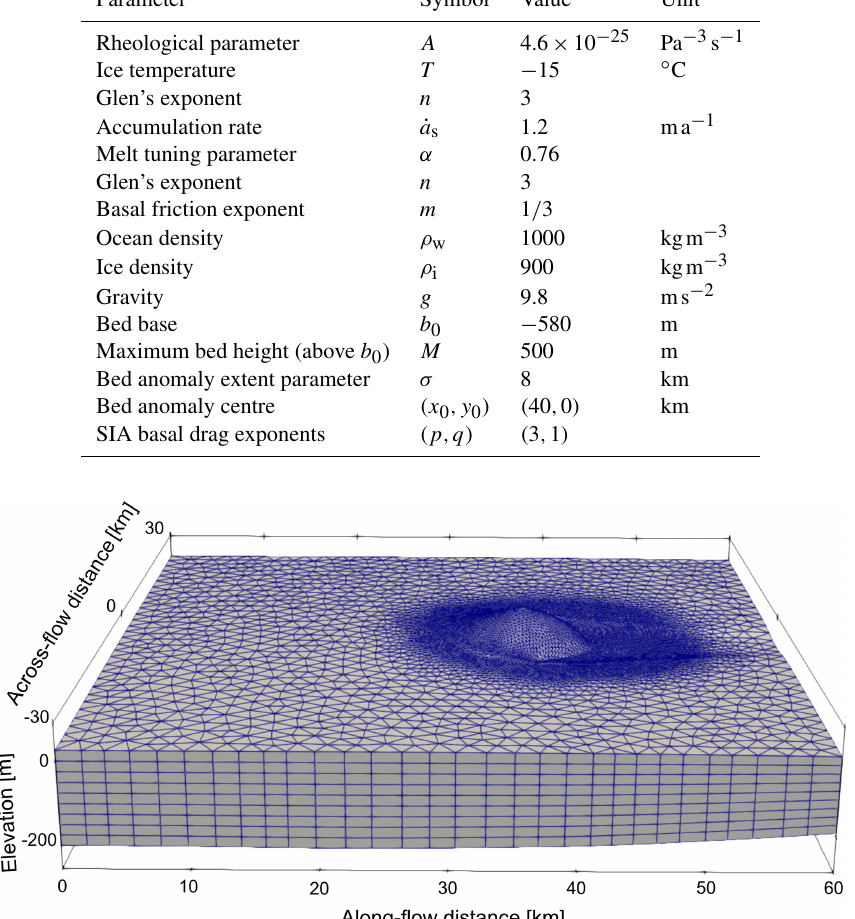
Figure 2. Shown is the mesh resolution. In the horizontal, the mesh is unstructured and has a resolution of 350m in the area surrounding the ice rise or ice rumple. The background resolution (of the surrounding ice shelf) is 2000m. The mesh is extruded in the vertical with 10 layers. Note that the geometry is exaggerated by a factor of 30 in the vertical